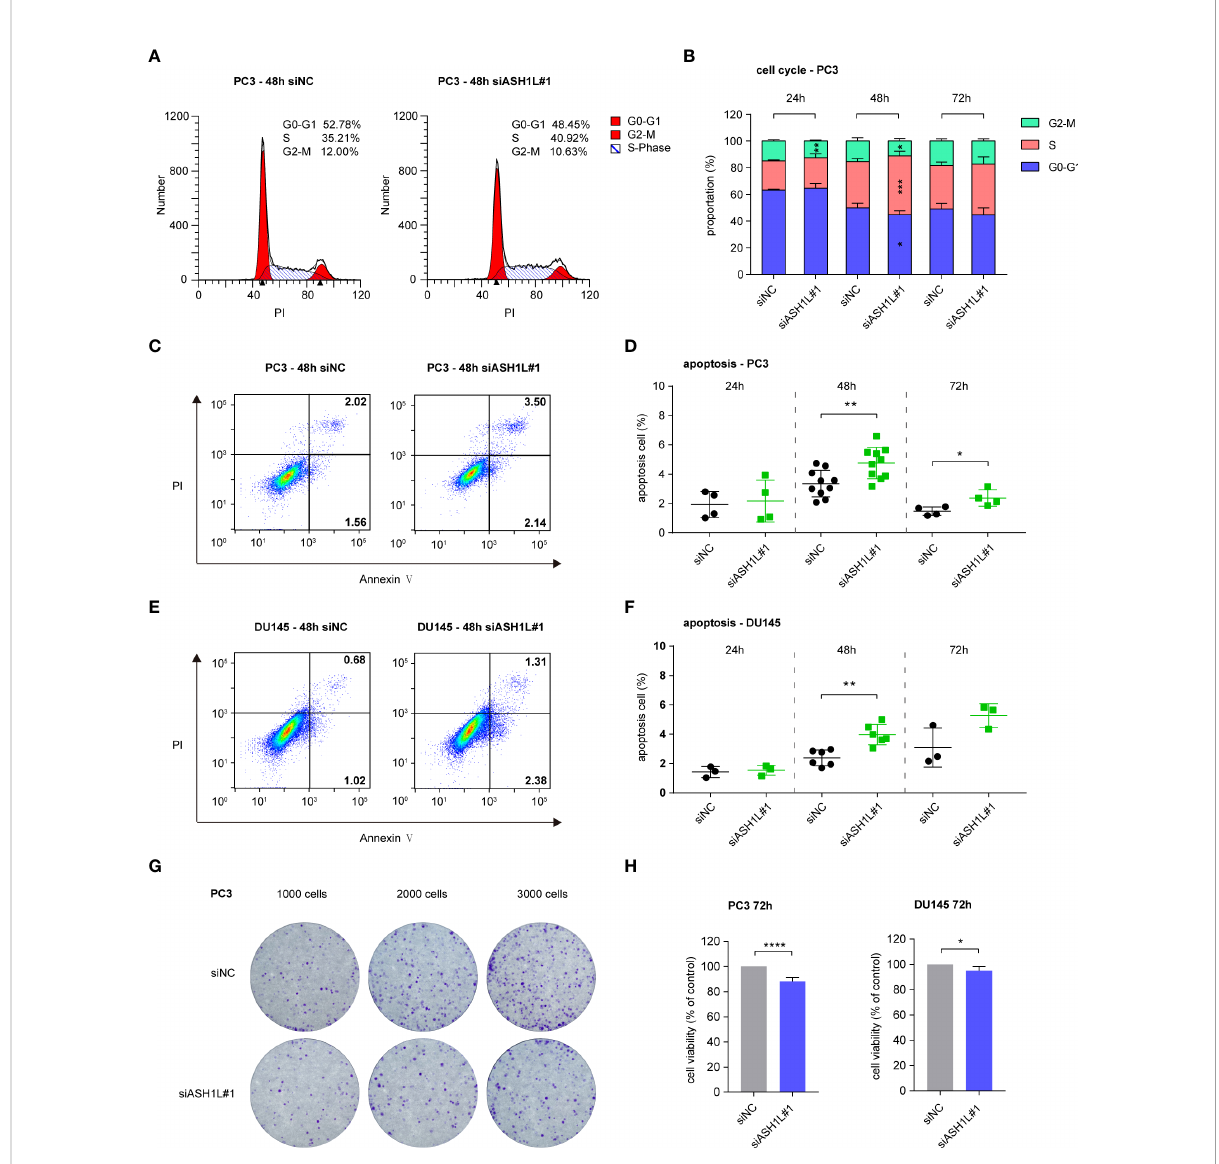
FIGURE 5 ASH1L knockdown induced cell cycle arrest and apoptosis but did not affect cell viability. (A) Representative fl ow cytometry images about the cell cycle distribution of PC3 at 48 h after siNC and siASH1L#1 transfection. (B) Cell cycle analysis of PC3 at 24, 48, and 72 h after siNC and siASH1L#1 transfection. (C) Representative fl ow cytometry images showing the proportion of early apoptotic (Annexin V + PI - ) and late apoptotic (Annexin V + PI + ) PC3 cells at 48 h after siNC and siASH1L#1 transfection. (D) Apoptosis level of PC3 detected by Annexin V/PI staining at 24, 48, and 72 h after siNC and siASH1L#1 transfection. (E) Representative fl ow cytometry images showing the proportion of early apoptotic (Annexin V + PI - ) and late apoptotic (Annexin V + PI + ) DU145 cells at 48 h after siNC and siASH1L#1 transfection. (F) Apoptosis level of DU145 detected